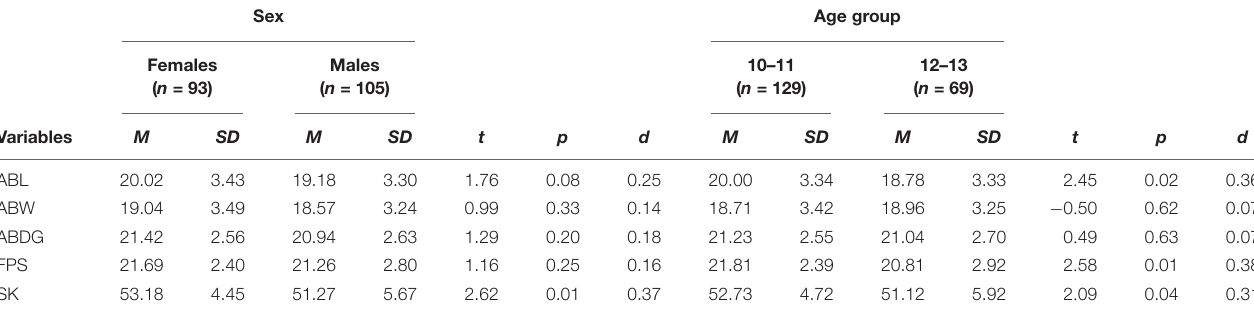
TABLE 1 | Mean differences by sex and age group.